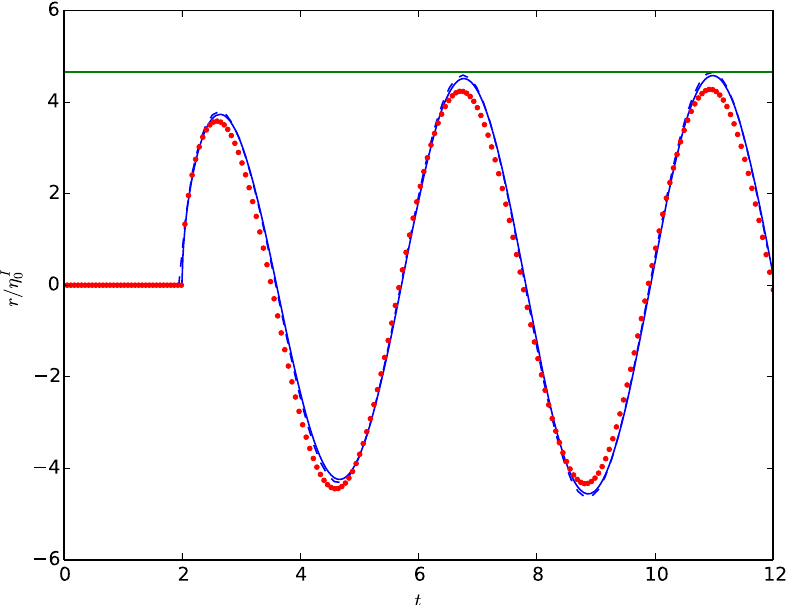
Figure 3. Continuous and dashed blue curves display the run-up normalised to the amplitude of incident wave for Model-1 with D = 0. The frequency of the incident wave is equal to the real part of the first-mode resonant frequency ω 1 (see Table 1). The continuous blue curve is obtained from the series of residues (see Eq. 26). The dashed blue curve is the run-up calculated using the fast Fourier transform approach. The green horizontal line on the top part of the figure is the limiting amplitude given by ω I | A 0 (ω I ) | /η I , where ω I is the frequency of 0 the incident wave. The red bullets are the run-up produced by a wave maker on an infinite constant slope. The action of the wave maker is δ(x − 1 ) cos ( (cid:60) ω 1 t)θ(t)/ (cid:60) ω 1 , where θ is the Heaviside function, represented by the “tsunamigenic” seafloor motion given by h(t,x) = − 2 η I 0 h is the seafloor uplift and (cid:60) denotes the real